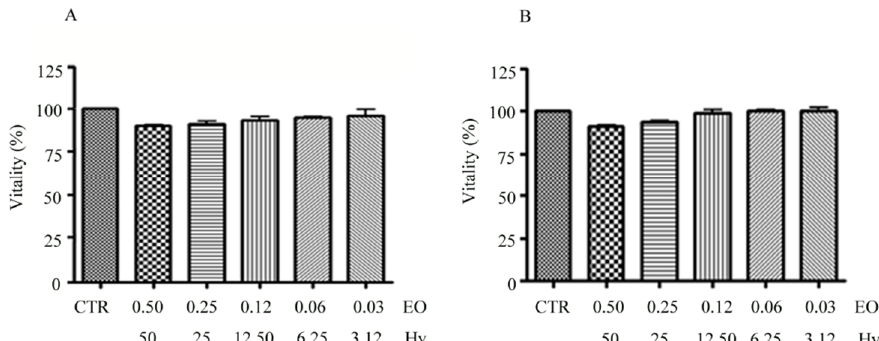
Figure 4. Cytotoxicity tests. Cytotoxicity assays performed with a Cell Titer Blue viability assay on human gingival fibroblasts at 24 ( A ) and 48 h ( B ) upon cell synchronization (24 h). Cells were treated with scalar dilution of a 1:100 v / v mixtures of Citrus aurantium var. amara EO (0.50% v / v to 0.06% v / v ) and Vitis vinifera cv Italia Hy (50% v / v to 6.25%).